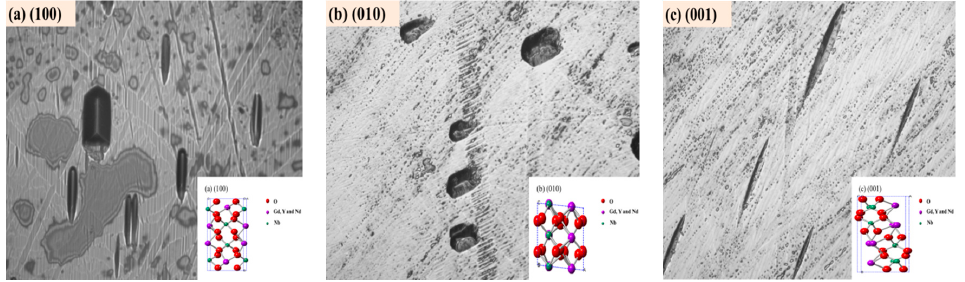
Figure 3. Dislocation etching pit patterns of Nd:GdYNbO 4 crystal at three different crystalline faces: ( a ) (100); ( b ) (010); and ( c ) (001).